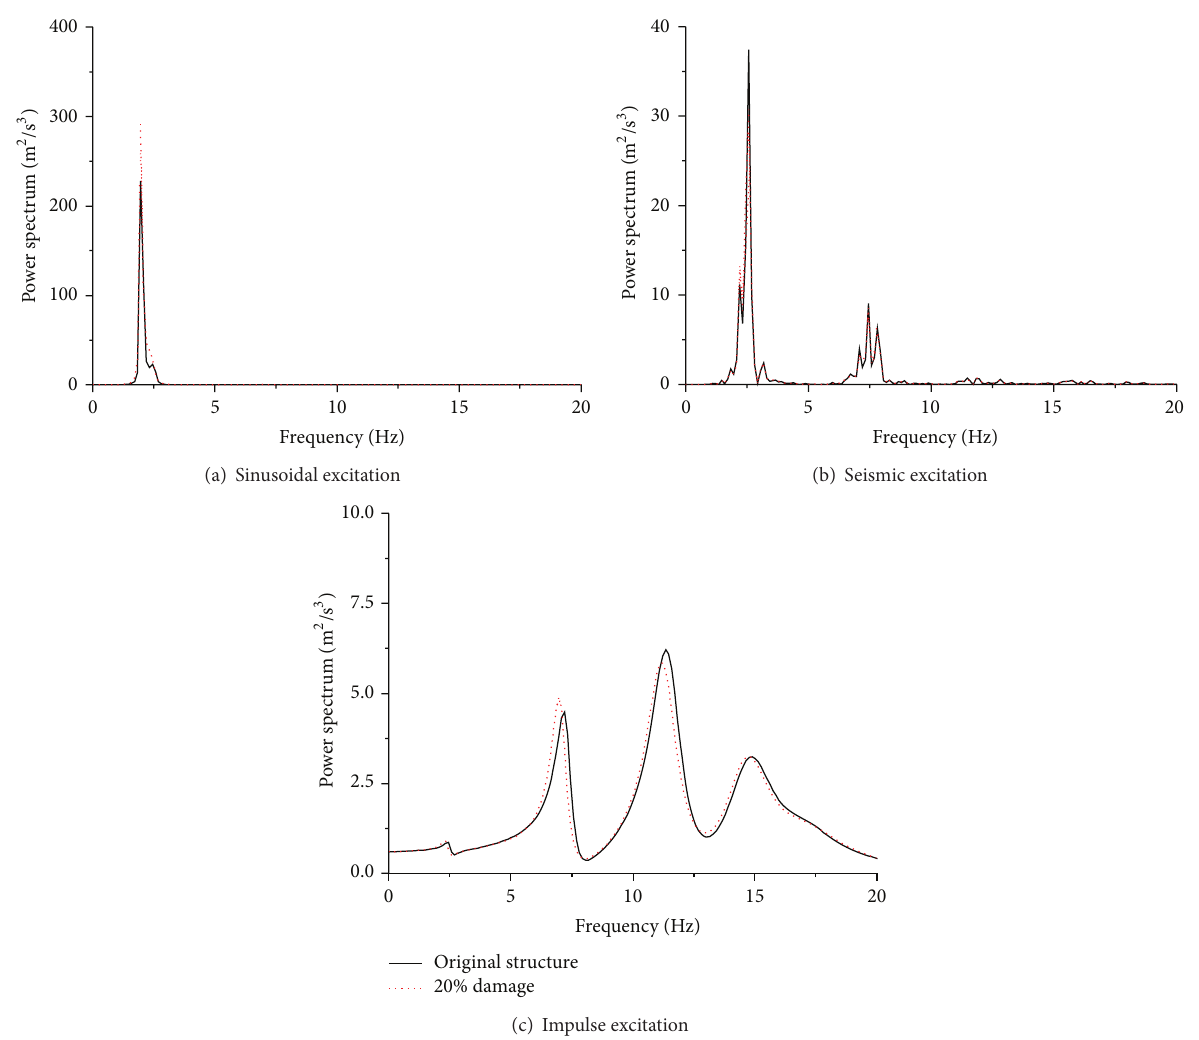
Figure 5: Power spectrum of acceleration responses of the first floor before and after sudden damage event.